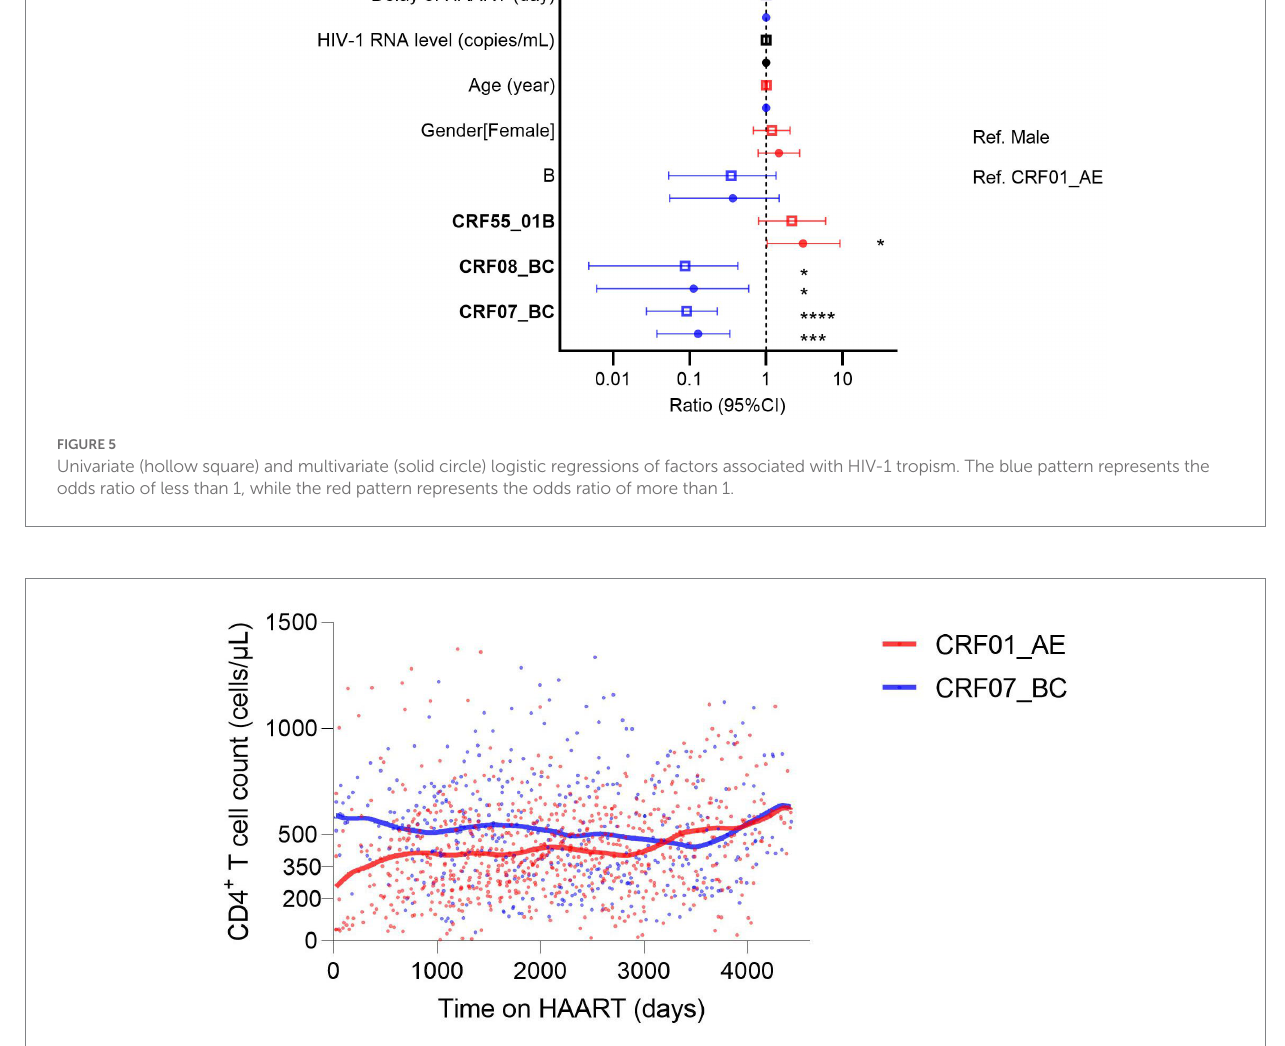
FIGURE 6 CD4 + T cell trajectories during HAART based on HIV-1 CRF01_AE and